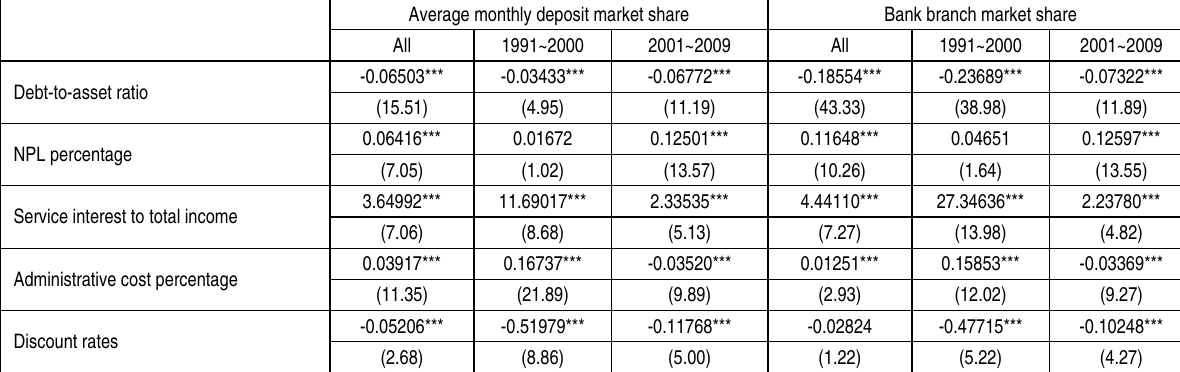
Table 2. Deposit and branch market shares – base